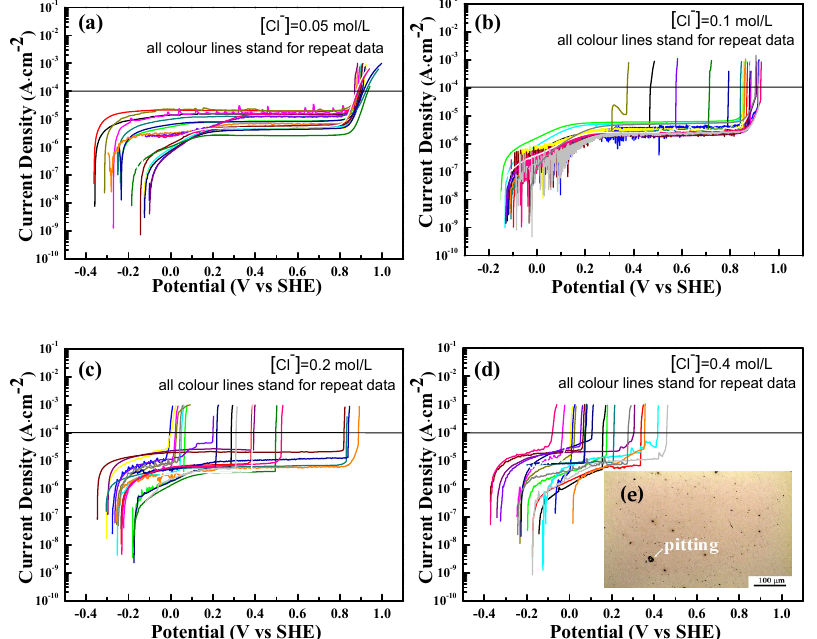
Figure 3. Anodic polarization curves for reinforcing bars in simulated concrete pore solutions with various concentration of chloride ions at pH 12.5; ( a ) 0.05 mol / L, ( b ) 0.1 mol / L, ( c ) 0.2 mol / L, and ( d ) 0.4 mol / L. ( e ) shows the pitting corrosion after the anodic polarization test.